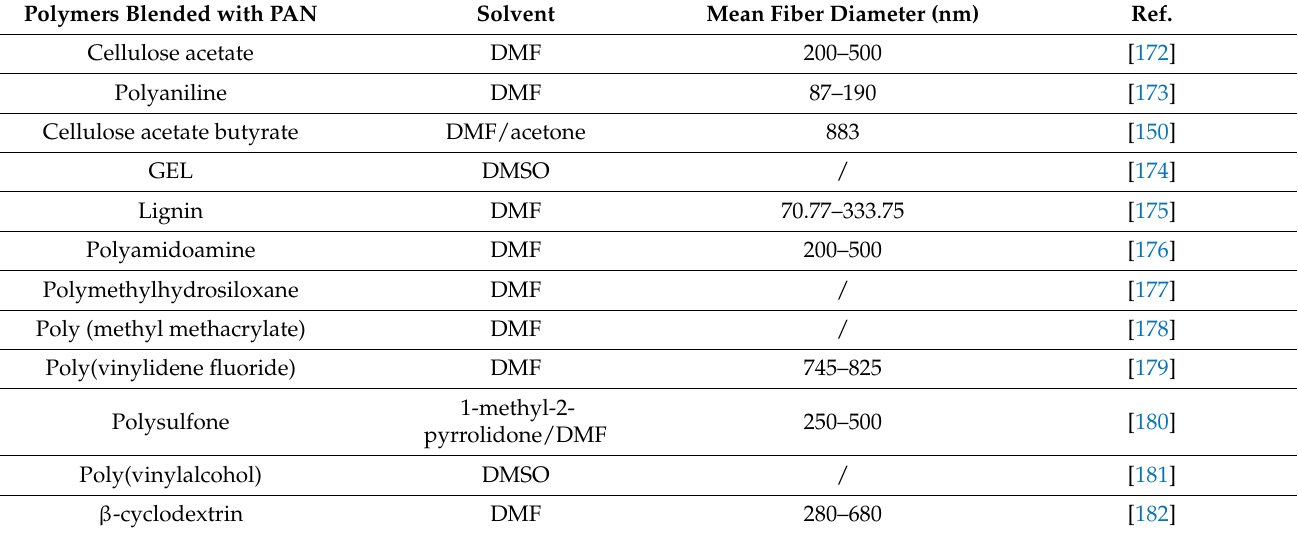
Table 1. Some polymers are blended with PAN for